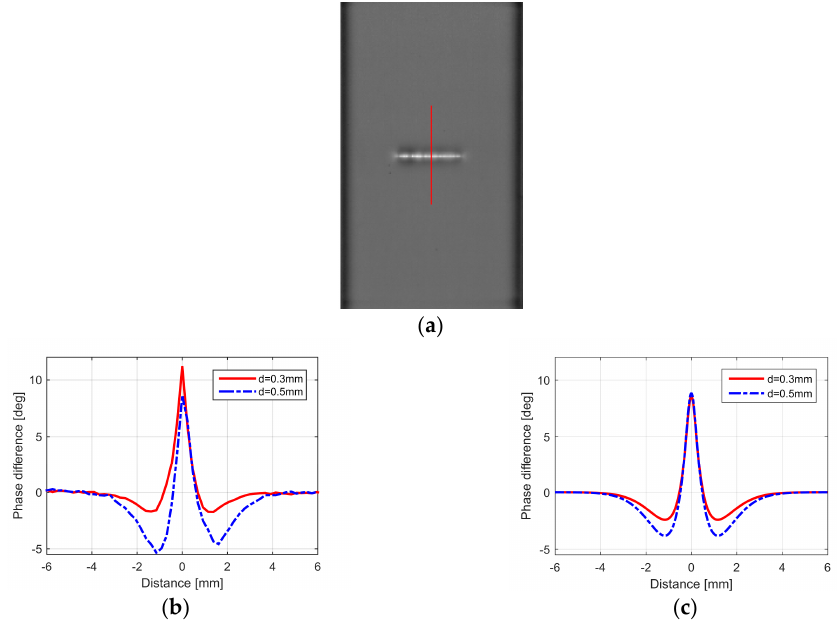
Figure 10. ( a ) Phase images of two samples measured with a pulse duration of 0.1 s. The left sample has a depth of approximately 0.3 mm, and the right one a depth of 0.5 mm; ( b ) two profiles through the images along the marked red lines; ( c ) simulated phase profiles.